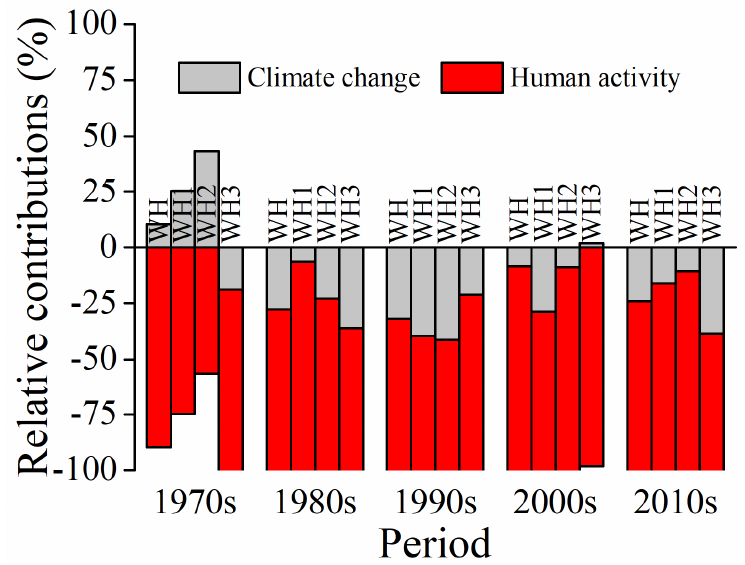
Figure 12. Relative contributions of climate change and human activity on runoff variation of the Weihe River basin and the three sub-regions in each decade since the 1970s.